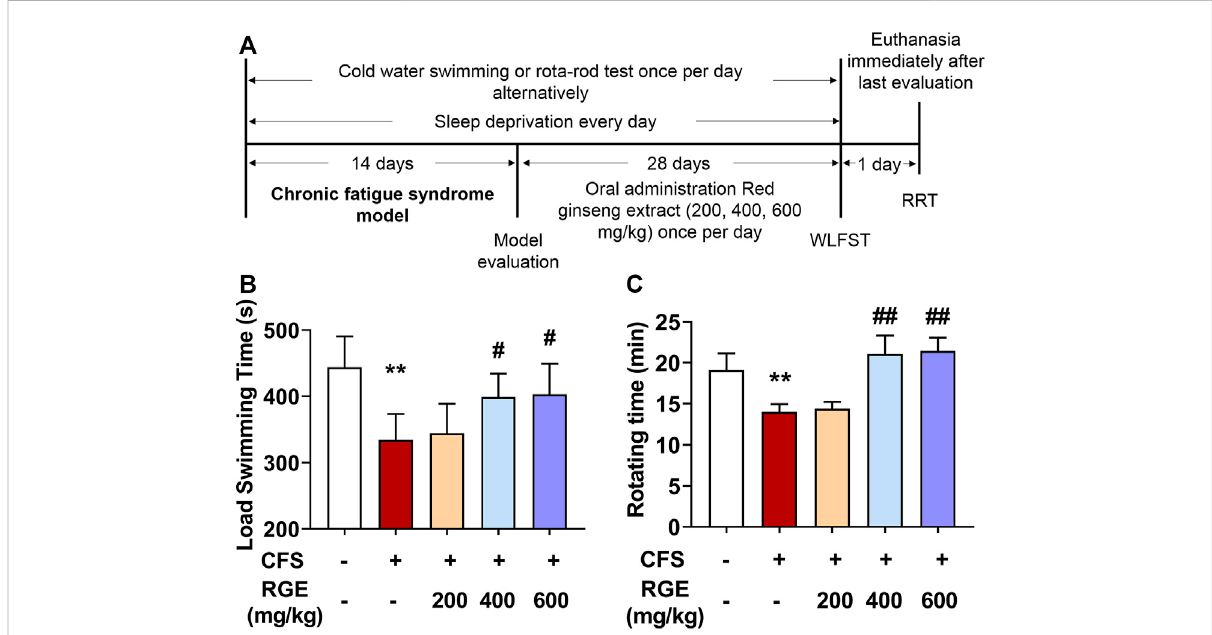
FIGURE 1 The effects of red ginseng extract (RGE) on weight-loaded forced swimming test (WLFST) and rota-rod test (RRT) in multiple stress factors- induced chronic fatigue syndrome mice. (A) . Experiment scheme of the study. (B,C) . Load swimming time (B) and rotating time (C) were recorded in the WLFST and RRT after the last administration of RGE or vehicle at 44th or 46th day. Mice from control or chronic fatigue syndrome model group were treated with water or different dose of RGE (200, 400 or 600 mg/kg). n = 13 mice per group. Compared with control group, ** p < 0.01; compared with CFS group, # p < 0.05, ## p <